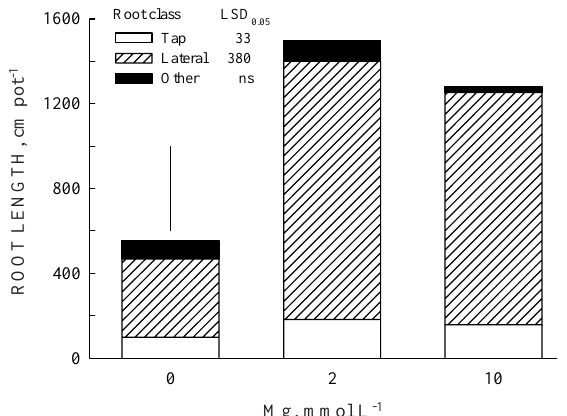
Figure 2. Mean total length in the subsurface compartment as a function of root classes for soybean genotypes N93-S-179 (N93) and Young after 12 days of exposure to solution Mg treatments in Experiment 1 containing no Al, 2 mmol L -1 Ca and maintained at pH 4.6. Least significant difference values are for the main effects of Mg on individual root classes and total root length (vertical line); ns stands for non significant at p < 0.05.